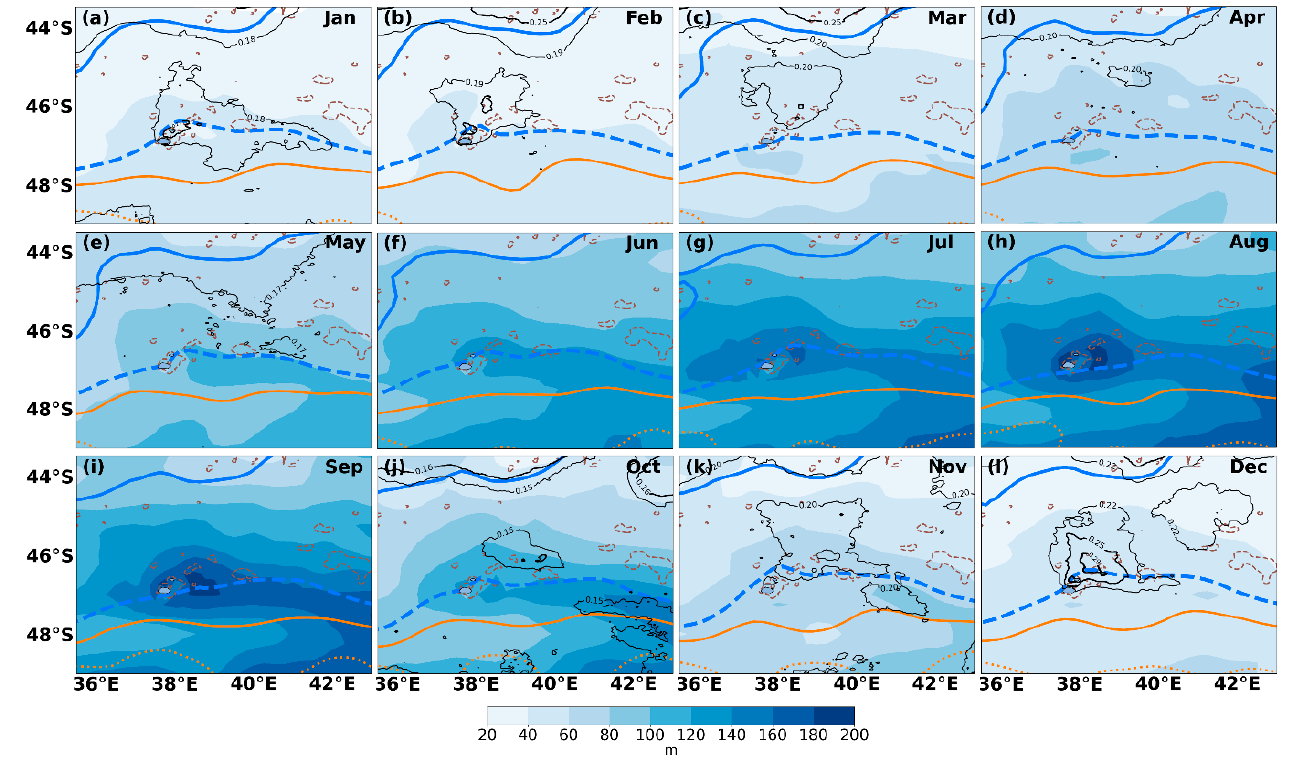
Figure 9. (a – l ) Monthly (January to December) climatology (1993–2019) of the ORAS5 simulated mixed layer depth (m). The black contours indicate the lowest and highest chla (mg m − 3 ) concentra- tions that formed unique closed contours in our region of interest (0.18 and 0.25 in January, 0.19 and 0.25 in February, 0.20 and 0.25 in March, 0.20 in April, 0.17 in May, 0.15 and 0.16 in October, 0.20 and 0.25 in November, 0.22, 0.25, and 0.29 in December). The dashed brown contours indicate the 1000 m isobath. The solid and dashed thick blue lines show the climatological mean positions of the middle (M-SAF) and southern (S-SAF) branches of the sub-Antarctic Front, respectively. The solid and dotted thick orange lines illustrate the climatological mean positions of the northern (N-APF) and middle (M-APF) branches of the Antarctic Polar Front,